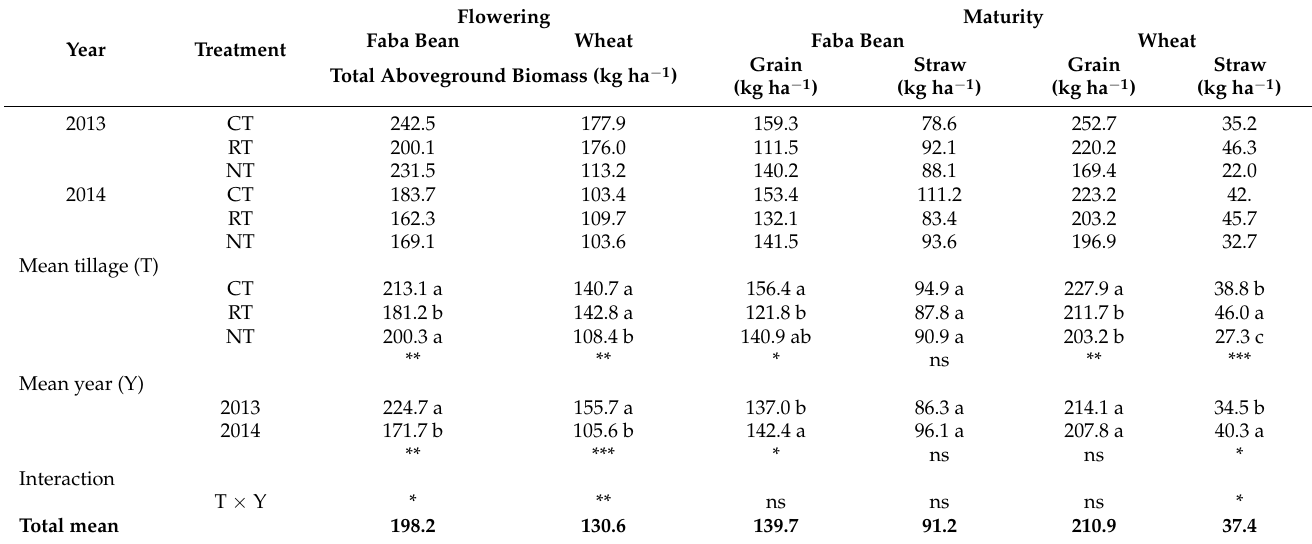
Table 4. N uptake by faba bean and wheat crop at two growth stages with respect to tillage system and study year.